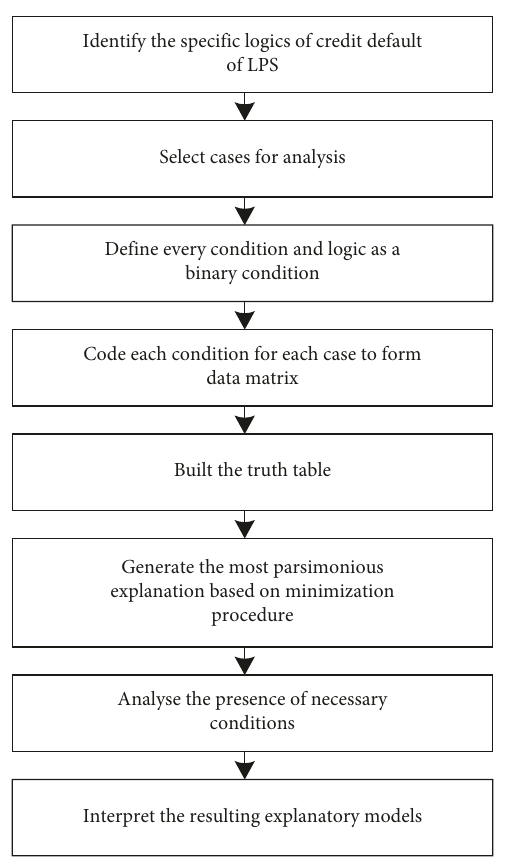
Figure 6: Steps of applying